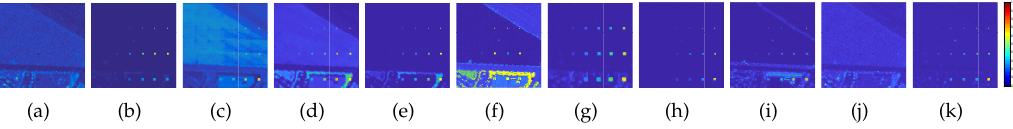
Figure 9. Two-dimensional plots of the detection results obtained by different methods for the synthetic dataset. ( a ) GRX; ( b ) BJSRD; ( c ) LSAD; ( d ) LRASR; ( e ) LSMAD; ( f ) CBAD; ( g ) CRD; ( h ) LRX; ( i ) LKRX; ( j ) OSP; and ( k )